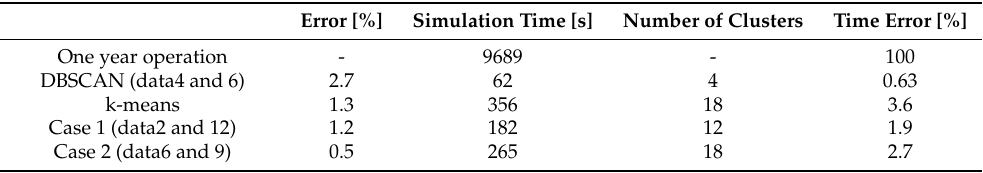
Table 4. Simulation results on the optimal data